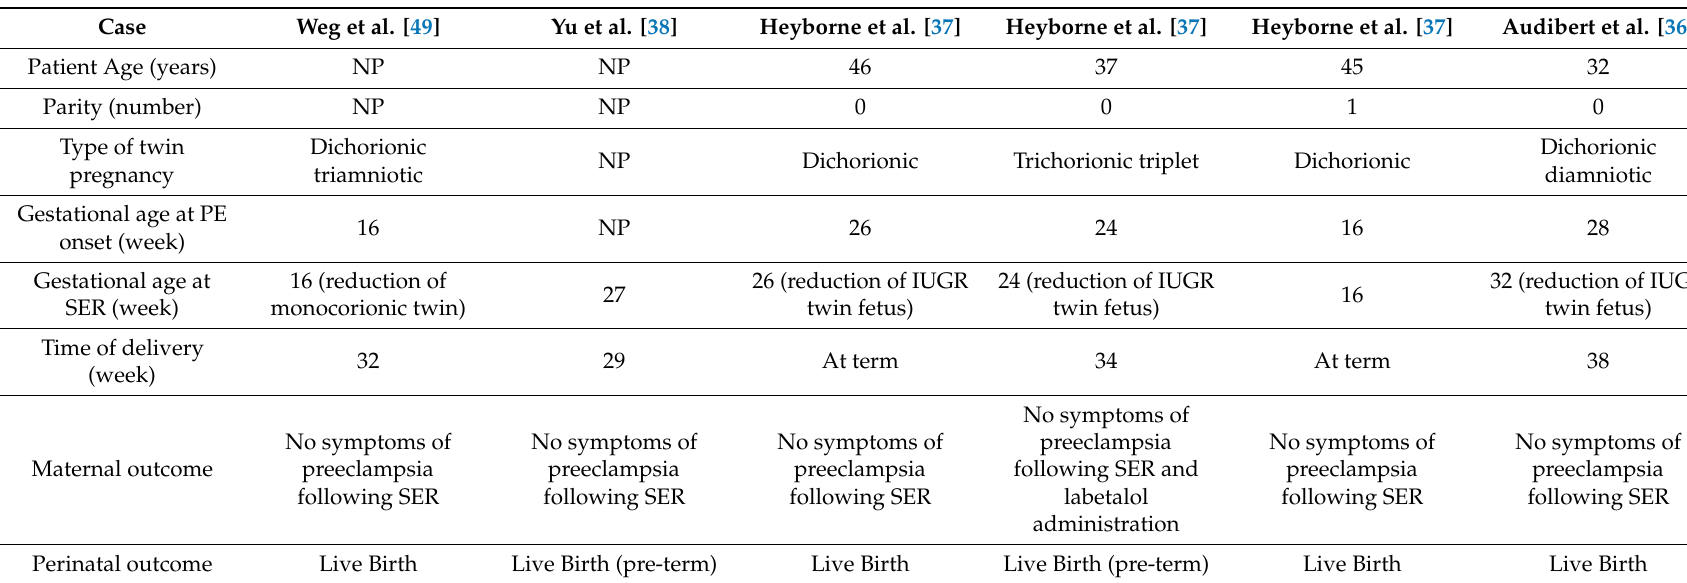
Table 2. Literature synthesis of case reports reported on selective embryo reduction for managing twin pregnancies complicated with